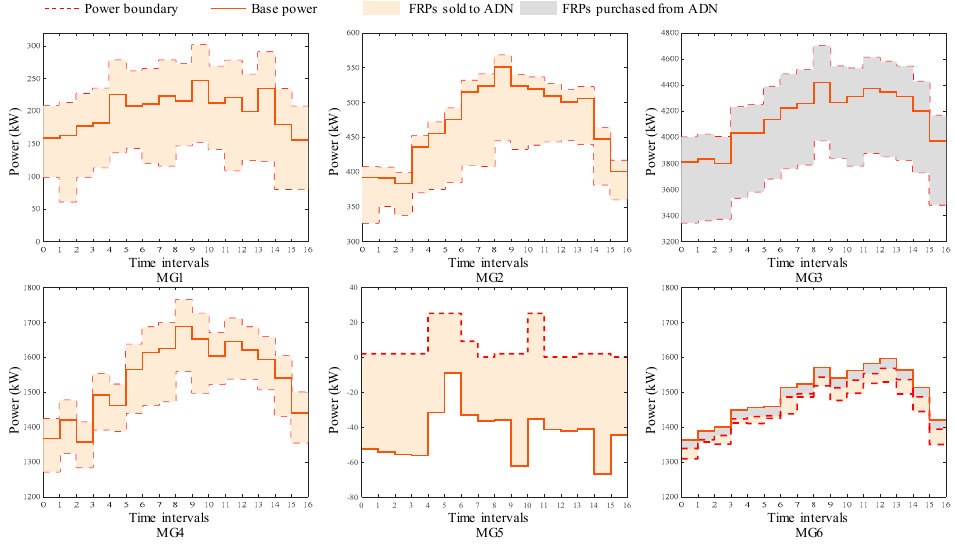
Figure 6. Optimization results of MGs. ADN1 and ADN2 converged after 11 and 13 iterations, respectively. The flexible/uncertain power ranges of ADN1 and ADN2 are shown in Figure 7. The robust minimum values are smaller than the robust maximum values of power in the ADN1 root node. This means that ADN1 can provide the TG with a flexible power range of about 10 MW after overcoming its uncertainties. However, the flexible resources in the ADN2 are not enough to offset the influence of internal uncertainties on the optimization results, resulting in an uncertain range (about 3% of its own basic power) to the TG. MG1, MG4~MG6, ADN1 and ADN2 contain REPG, of which the consumption rates are above 95% after optimization.